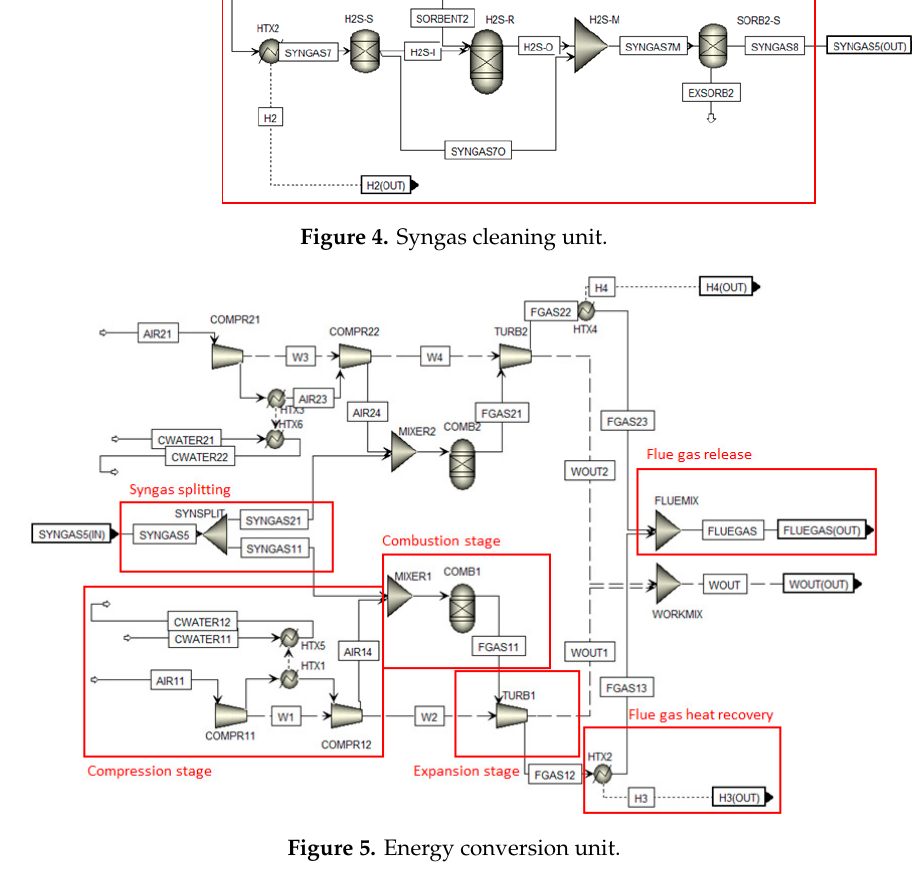
Figure 5. Energy conversion unit.